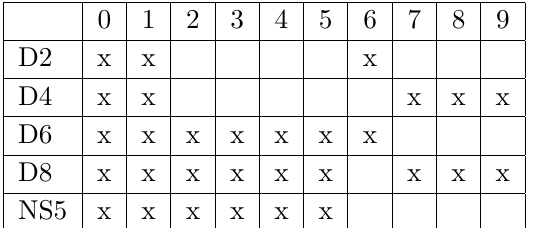
Table 1 . 1 -BPS brane intersection underlying the quiver depicted in (cid:12)gure 1. ( x 0 ; x 1 ) are the 8 directions where the 2d CFT lives, ( x 2 ; : : : ; x 5 ) span the CY 2 , on which the D6 and the D8-branes are wrapped, x 6 is the direction along the linear quiver, and ( x 7 ; x 8 ; x 9 ) are the transverse directions on which the SO(3) R symmetry is